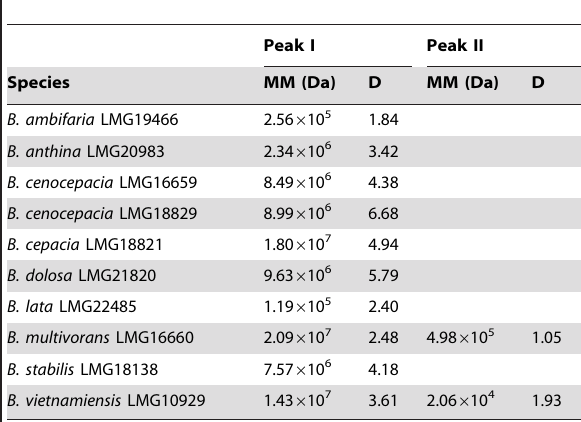
Table 4. Weight average molecular masses (MM, Da) and polydispersity index (D) of the EPOL fractions produced by the investigated BCC species.